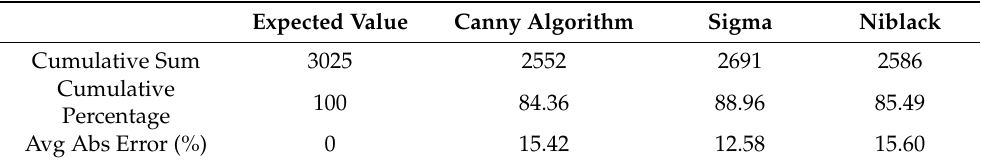
Table 5. Length in pixels of air line defects.